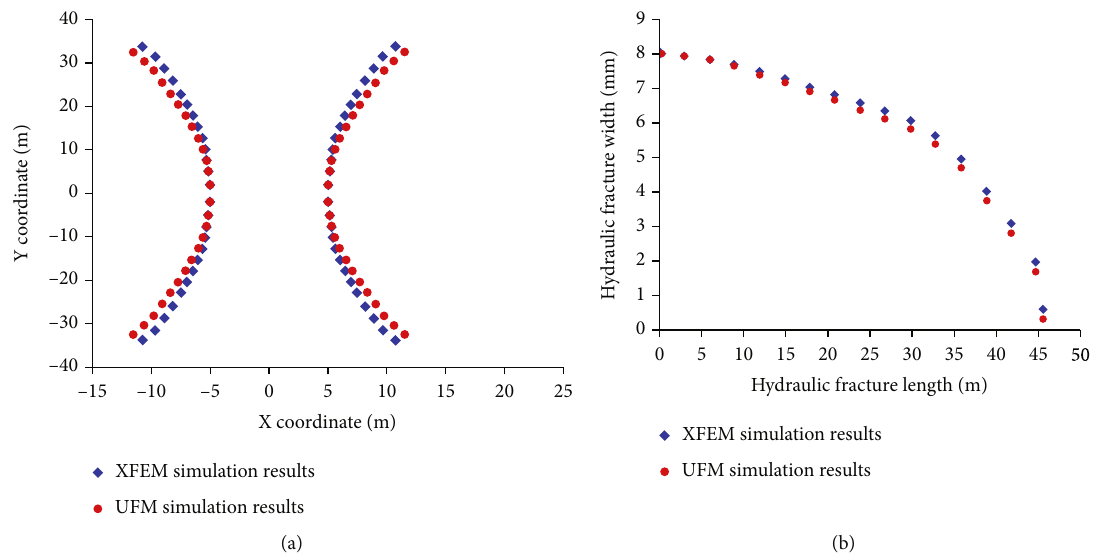
Figure 2: Comparison with unconventional fracture model (UFM): (a) hydraulic fracture geometry comparison and (b) comparison of hydraulic fracture length and width.